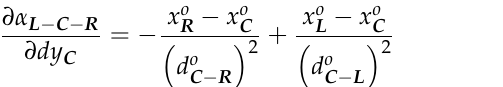
Figure 6. Back- line receivers’ post -processed coordinates from four sessions.